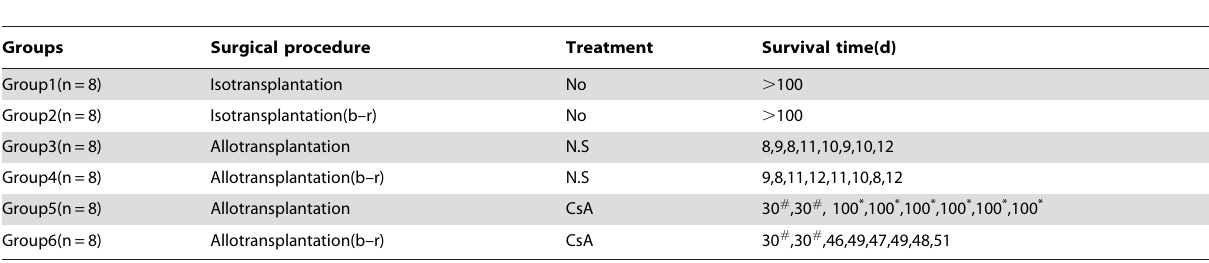
Table 1. Experimental design and survival time of the transplanted grafts.